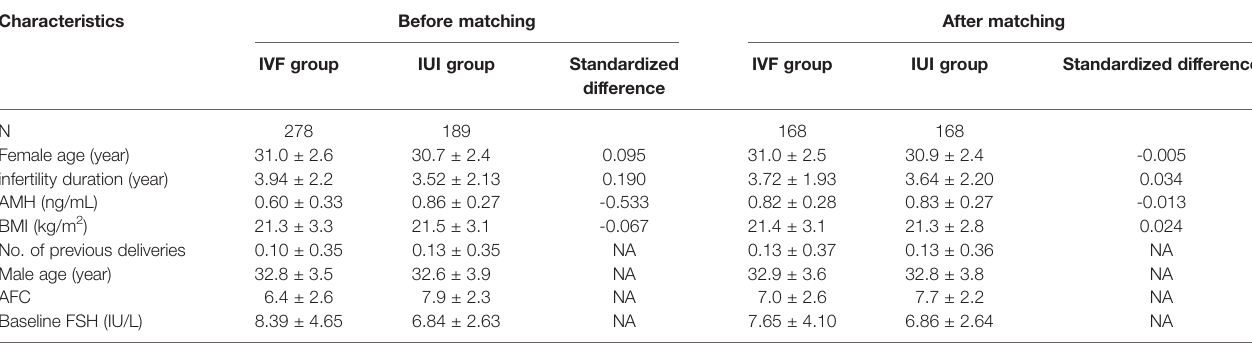
TABLE 1 | Characteristics of patients before and after PSM. Characteristics